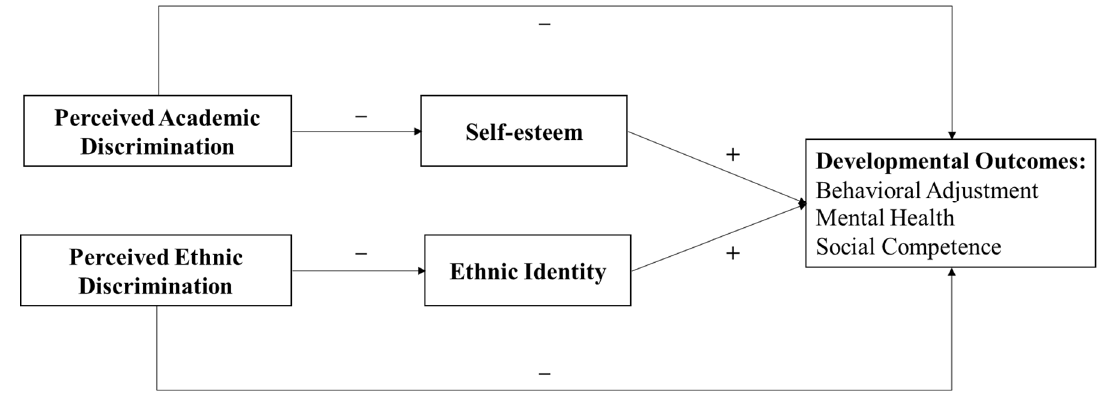
Figure 1. Theoretical framework and research hypotheses.